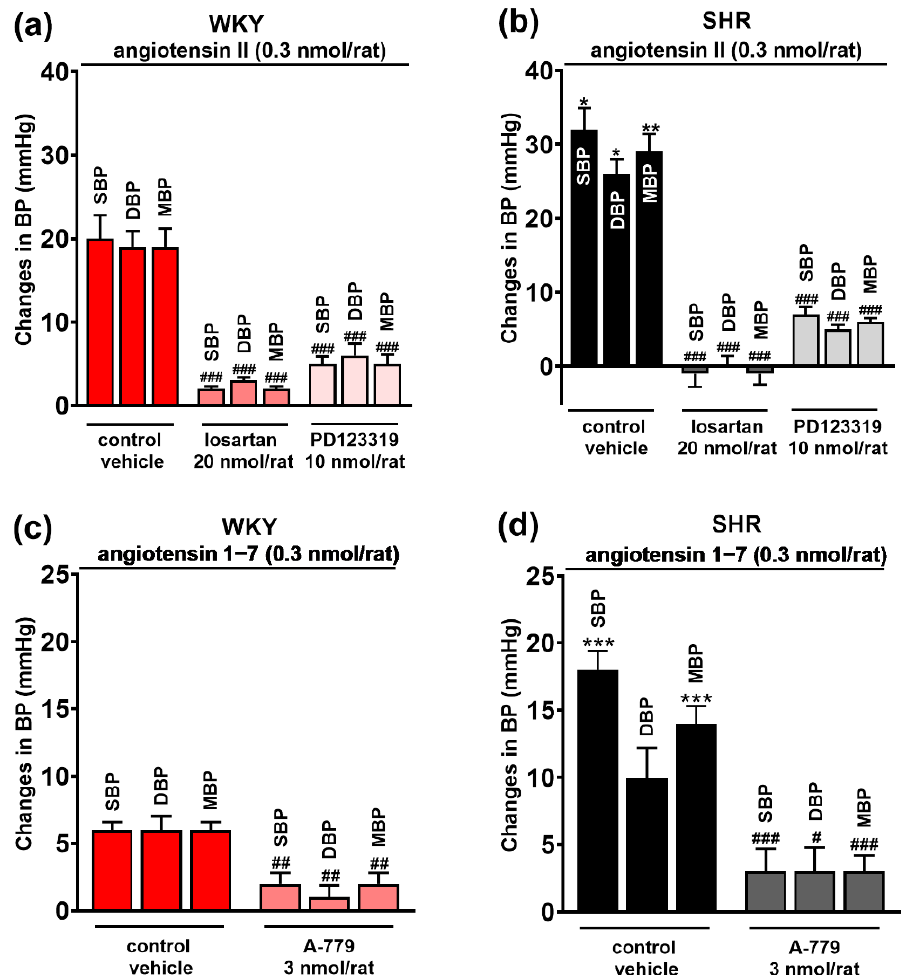
Figure 4. Effect of angiotensin II (AT 1/2 receptor agonist) ( a , b ) and angiotensin 1–7 (Mas receptor agonist) ( c , d ) on systolic (SBP), diastolic (DBP) and mean (MBP) blood pressure, and their interaction with AT 1 , AT 2 and Mas receptor antagonists (losartan, PD123319 and A-779, respectively) injected into the paraventricular nucleus of hypothalamus (PVN) in conscious Wistar Kyoto (WKY) and spontaneously hypertensive rats (SHR). Results are presented as mean ± SEM ( n = 7–8) and calculated as change in basal values determined before agonist injection. # p < 0.05, ## p < 0.01, ### p < 0.001 compared to the corresponding control group; * p < 0.05, ** p < 0.01, *** p < 0.001 compared to WKY.